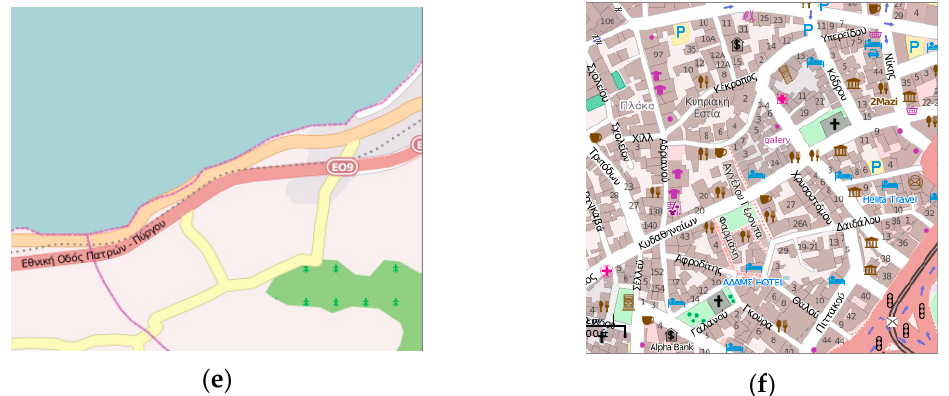
Figure 2. Generalization issues: ( a ) excessive detail in relation to the scale level in the road network; ( b ) very small buildings are portrayed; ( c ) different degree of generalization in the river network and the land use; ( d ) overlay problems between layers e.g. road network, urban area, park and lack of detail in layers e.g. the road network; ( e ) overlay problems between layers e.g. road network, land and sea; ( f ) problems in establishing information hierarchy.